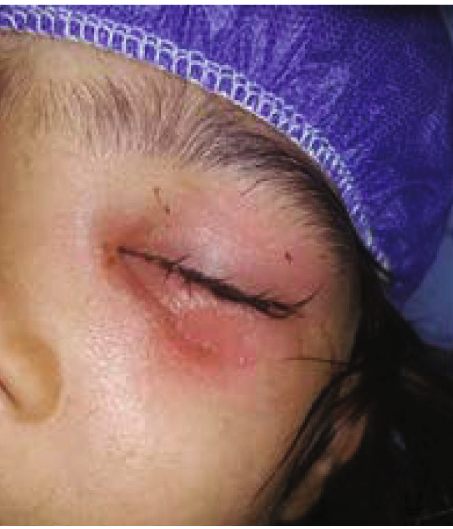
Figure 1: Edema of left upper and lower eyelids.